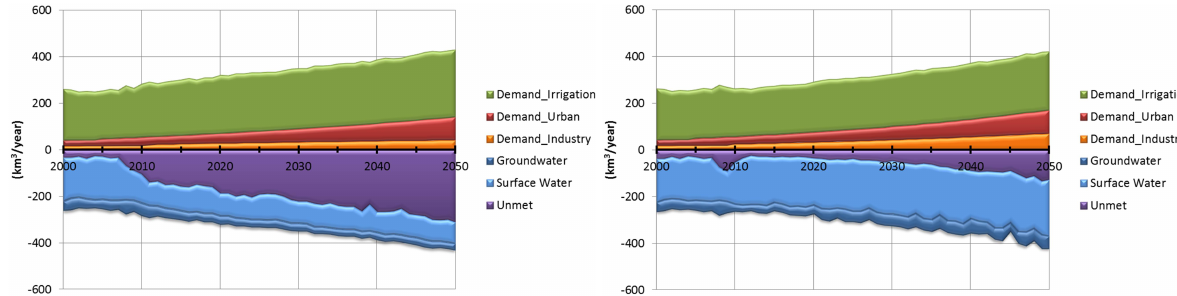
Fig. 8. Water demand and supply MENA for the climate scenario AVG (top) and DRY (middle) and WET (bottom).